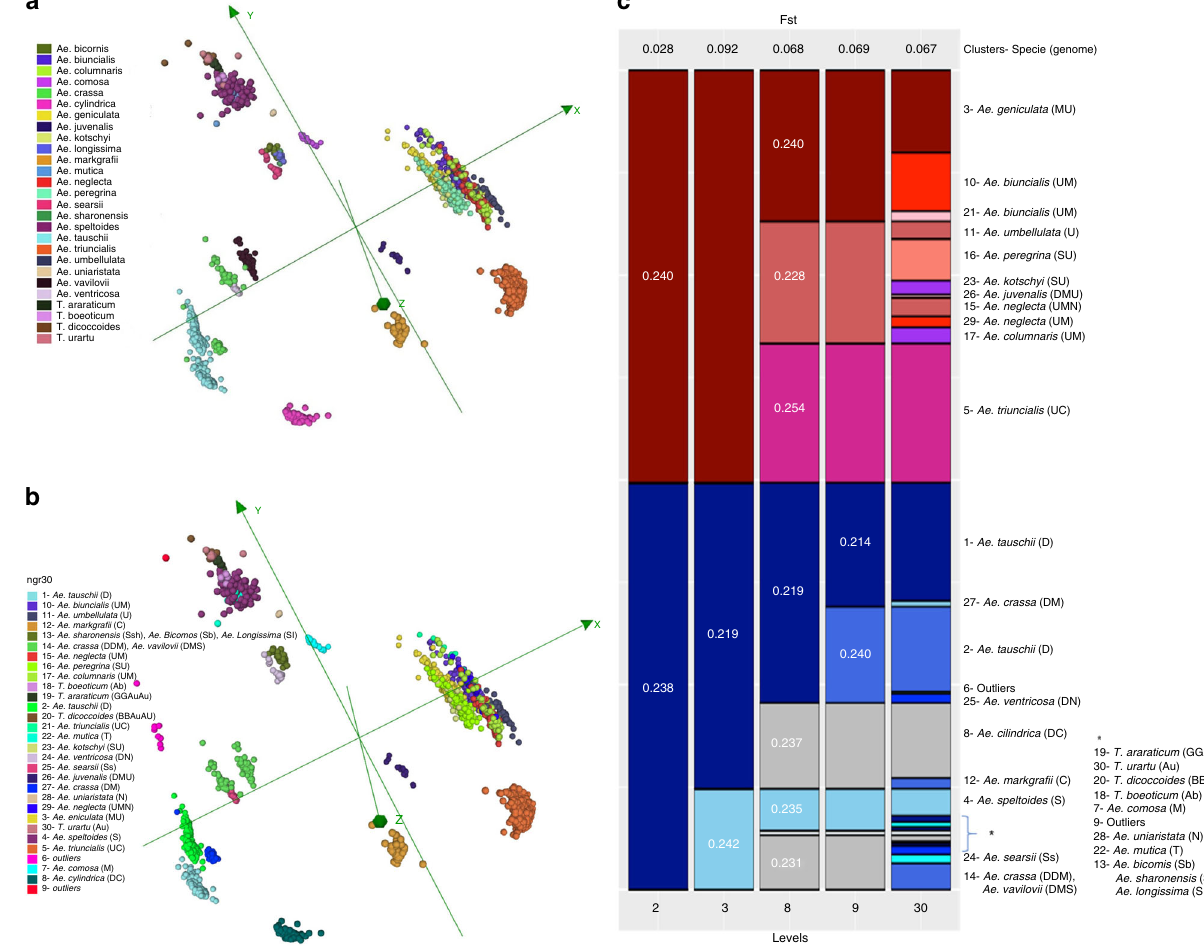
Fig. 3 Diversity analysis of CWR accessions. a Multidimensional scaling plot visualized in Curlywhirly of 3903 CWR accessions based on Jaccard distance using 61,505 SilicoDArT markers, including the 27 wild relative species; b CWR distributed in 30 clusters; c Representation of the distribution of 30 groups based on cluster analysis. The graph should be interpreted from left to right. The size of the boxes is proportional to the number of accessions. On the right edge are the numbers of the clusters, species name, and the genome constitution (bold) for each